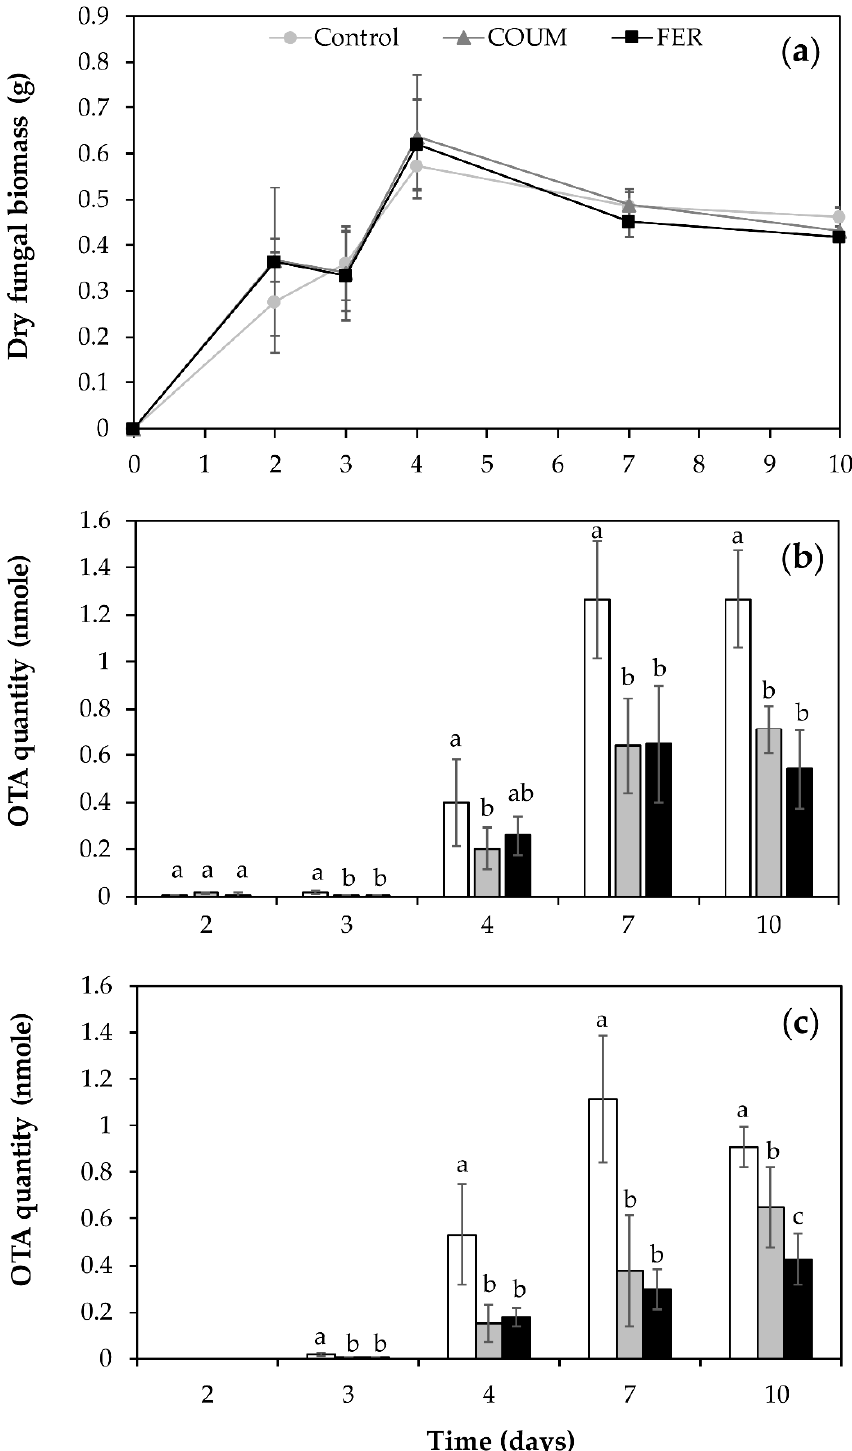
Figure 3. Kinetics of ( a ) fungal biomass and ochratoxin A (OTA) accumulated in ( b ) mycelia and in ( c ) supernatants of Penicillium verrucosum broths supplemented with 0.5 mM ferulic acid (FER) (black) and p -coumaric acid (COUM) (gray) or in nonsupplemented control (white). Differences between control and tested phenolic acids in terms of OTA were determined separately for each day with multiple comparisons tests using the Dunn–Sidak method. Different letters indicate significant differences ( p < 0.05). Values are expressed as means ± standard deviation using five biological replicates.